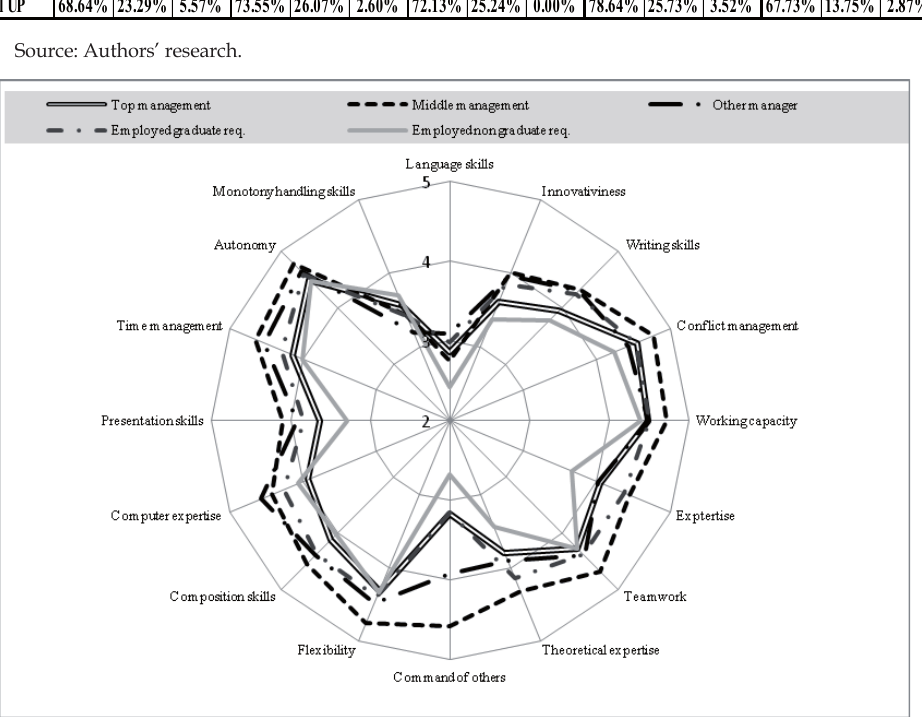
Figure 4. Working-related skills by the job position (n=1,215). Source: Authors’